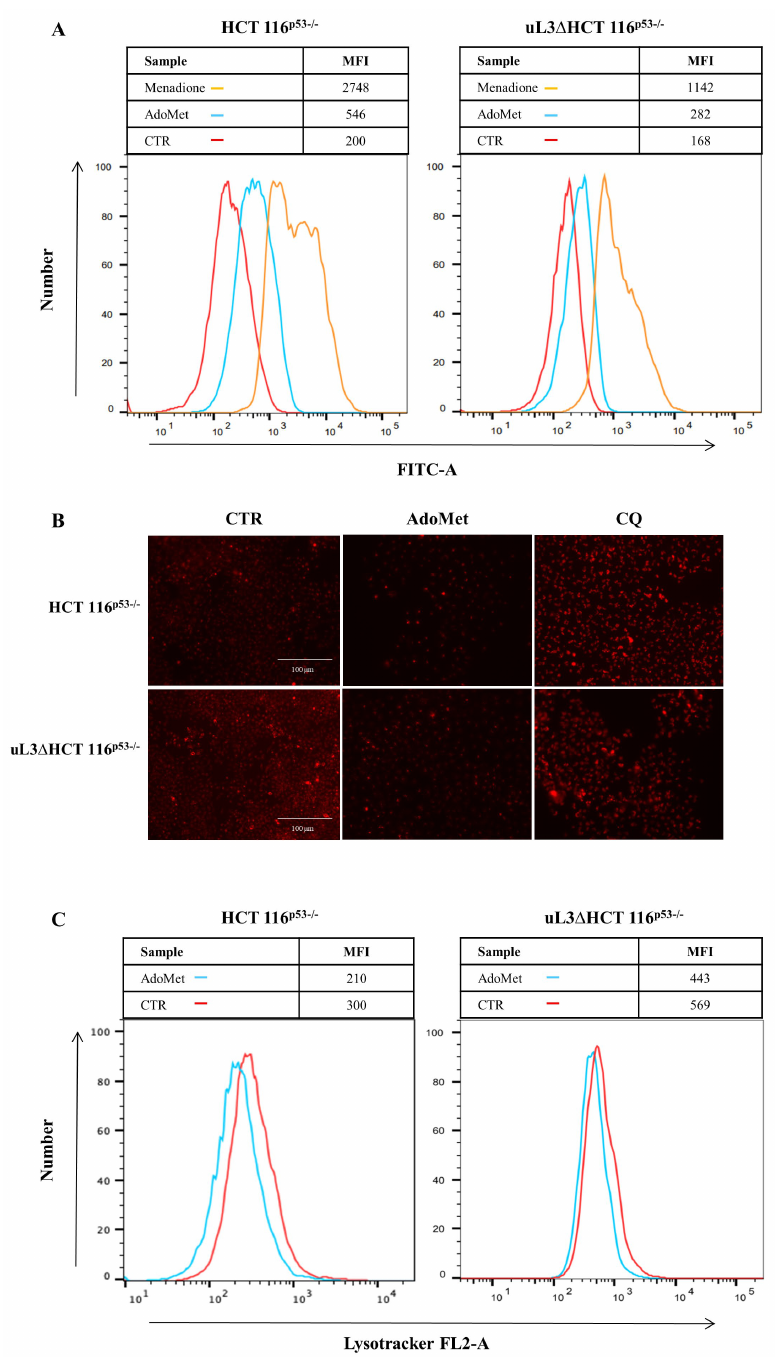
Figure 5. Effect of AdoMet on ROS accumulation and on autophagic flux in HCT 116 p53 −/− and uL3ΔHCT 116 p53 −/− colon cancer cells. ( A ) HCT 116 p53 − / − and uL3 ∆ HCT 116 p53 − / − cells were treated or not (CTR) with 500 µ M AdoMet for 72 h and than subjected to flow cytometry to measure ROS levels. FACS analysis was performed using 2′,7′ -dichlorofluorescein diacetate (DCF-DA) as a substrate. For the quantitative evaluation of ROS, FlowJo software was used to calculate median fluorescence intensities (MFI) by the formula (MFI-treated/MFI-control). Analysis was carried out by triplicate determina- tion on three separate experiments. ( B ) Representative images of vital dye LysoTracker (LTR) staining of HCT 116 p53 − / − and uL3 ∆ HCT 116 p53 − / − cells treated or not (CTR) with 500 µ M of AdoMet for 48 h analyzed by fluorescence microscopy. Chloroquine (CQ) was used as a positive control. ( C ) Flow cytometry analysis of HCT 116 p53 − / − and uL3 ∆ HCT 116 p53 − / − labeled with LTR. Median fluorescence values are shown in the graphs. At least 2 × 10 4 events were acquired in log mode. For the quantitative evaluation of LTR, FlowJo software was used to calculate median fluorescence intensities (MFI) by the formula (MFI-treated/MFI-control). The experiments were repeated three